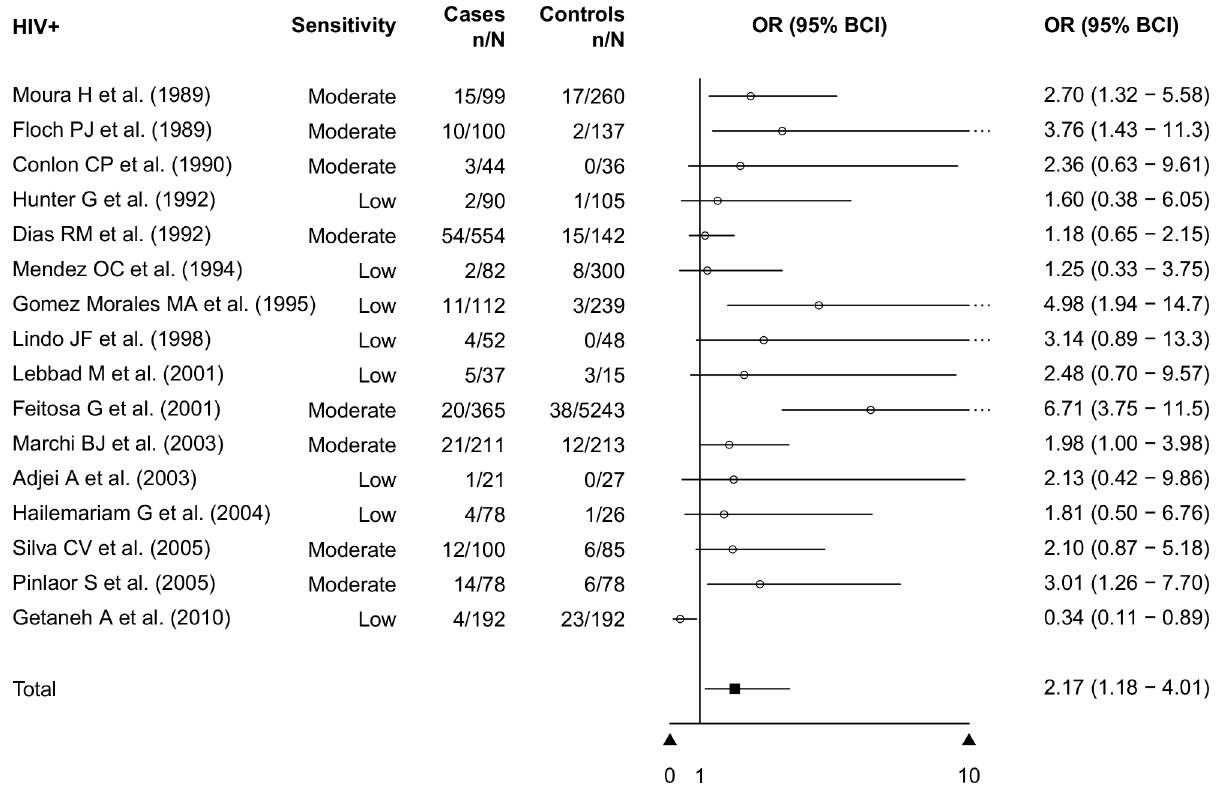
Figure 7. Risk of S.stercoralis infection in HIV/AIDS patients (meta-analysis of case-control studies).